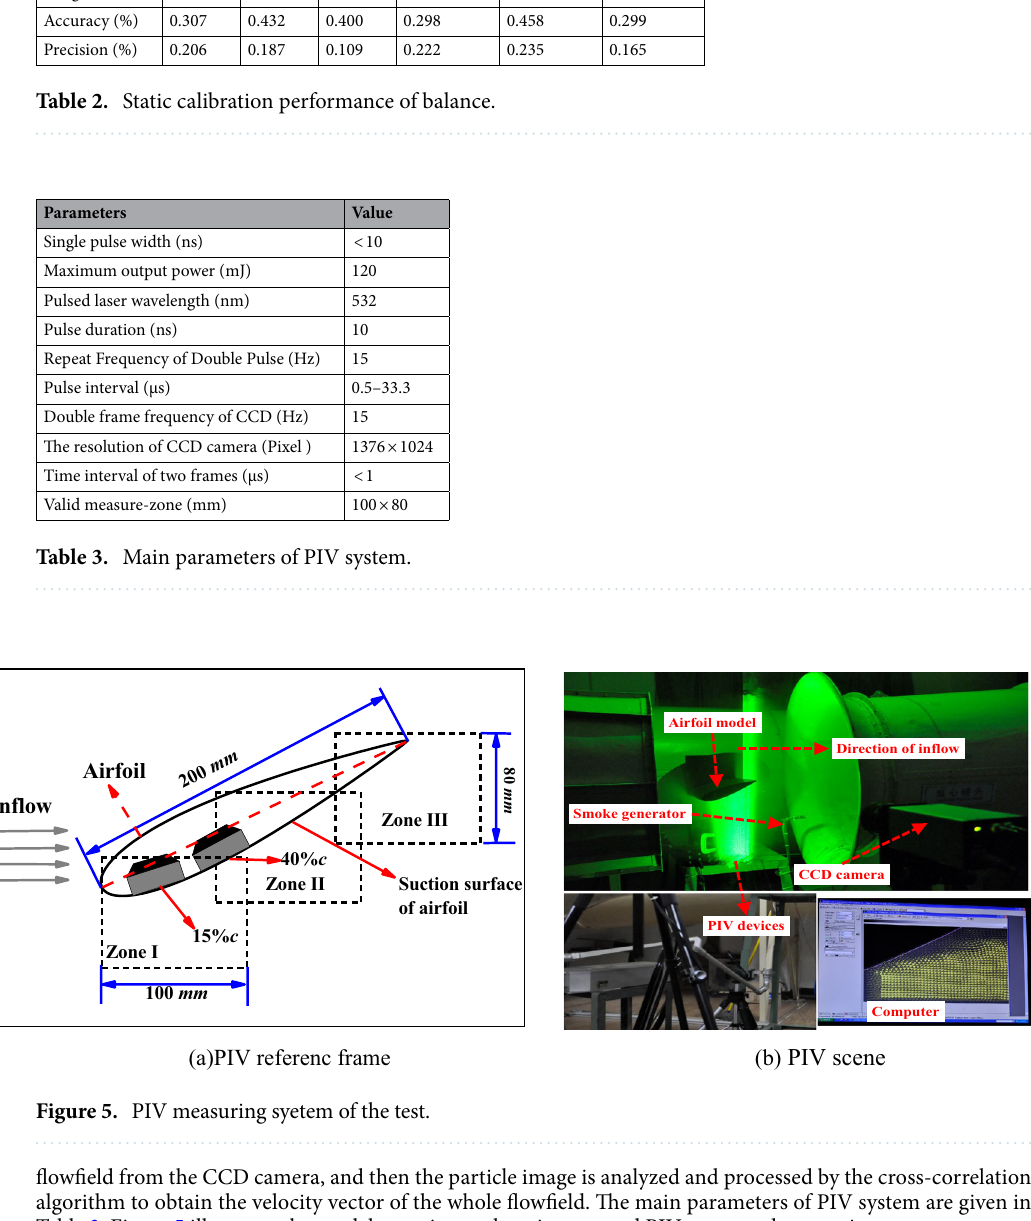
Fig. 6. The boundary layer probe test system consists of boundary layer probe (Preston tube), 8-Channel pressure